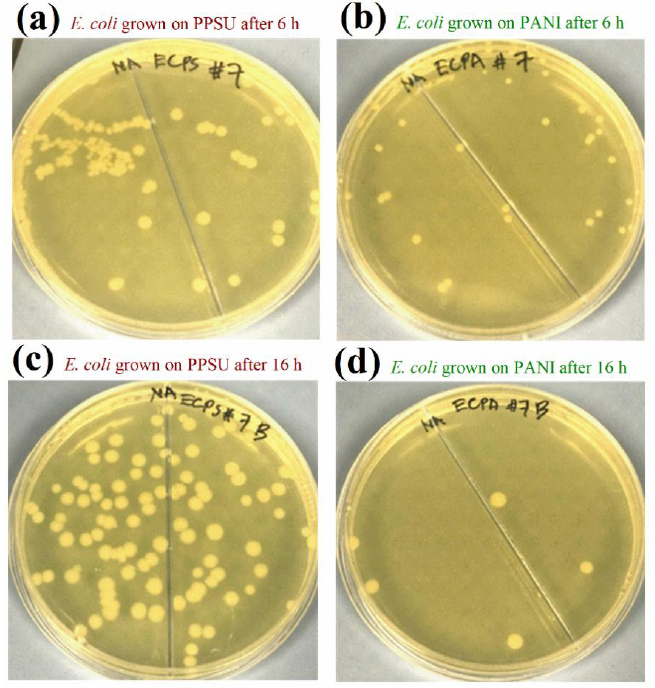
Figure 9. Antimicrobial properties of pristine PPSU and PANI-coated PPSU membranes assessed by plate counting. Plates incubated after the growth of E. coli on a pristine PPSU membrane for ( a ) 6 h and ( c ) 16 h. Plates incubated after the growth of E. coli on a PANI-coated membrane for ( b ) 6 h and ( d ) 16 h.